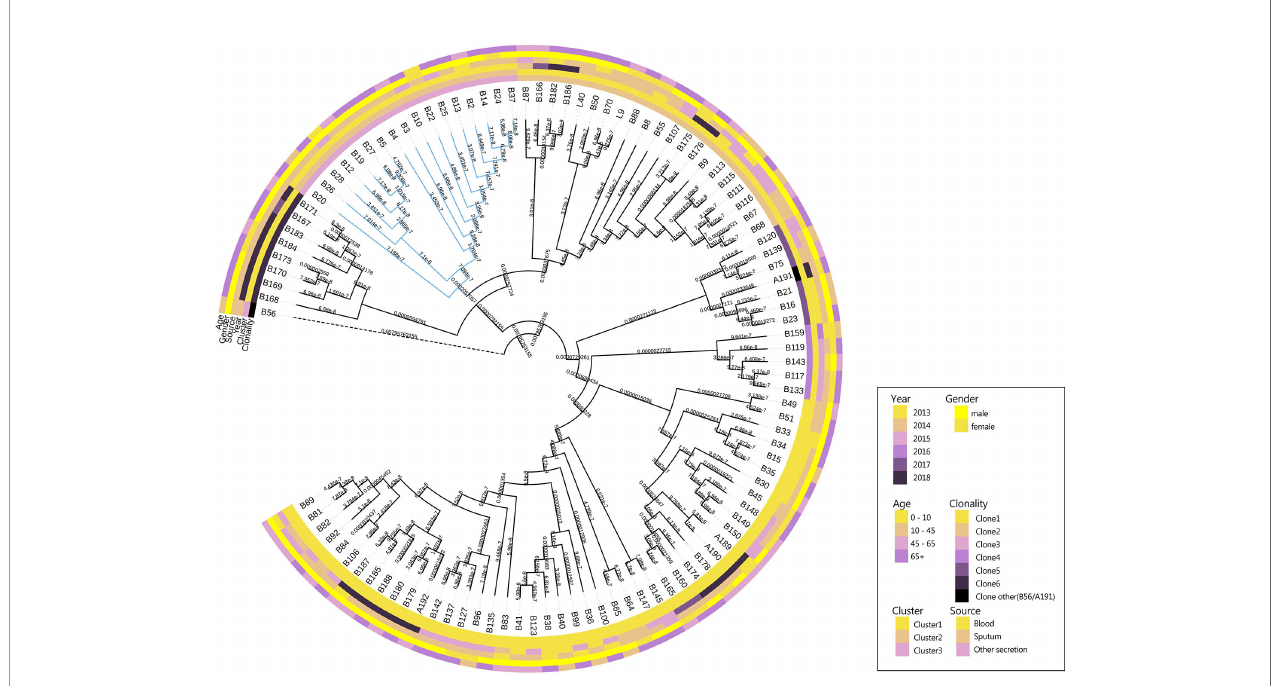
FIGURE 3 | Maximum likelihood phylogenetic trees from core genome alignments of CRAB isolates. Phylogenetic tree constructed from the core genomic fi le excluding the standard strain M19606; colored annotations are added next to the main tree for sampling time and sources, patient ages and genders and cluster and clonality classi fi cation of 105 CRAB